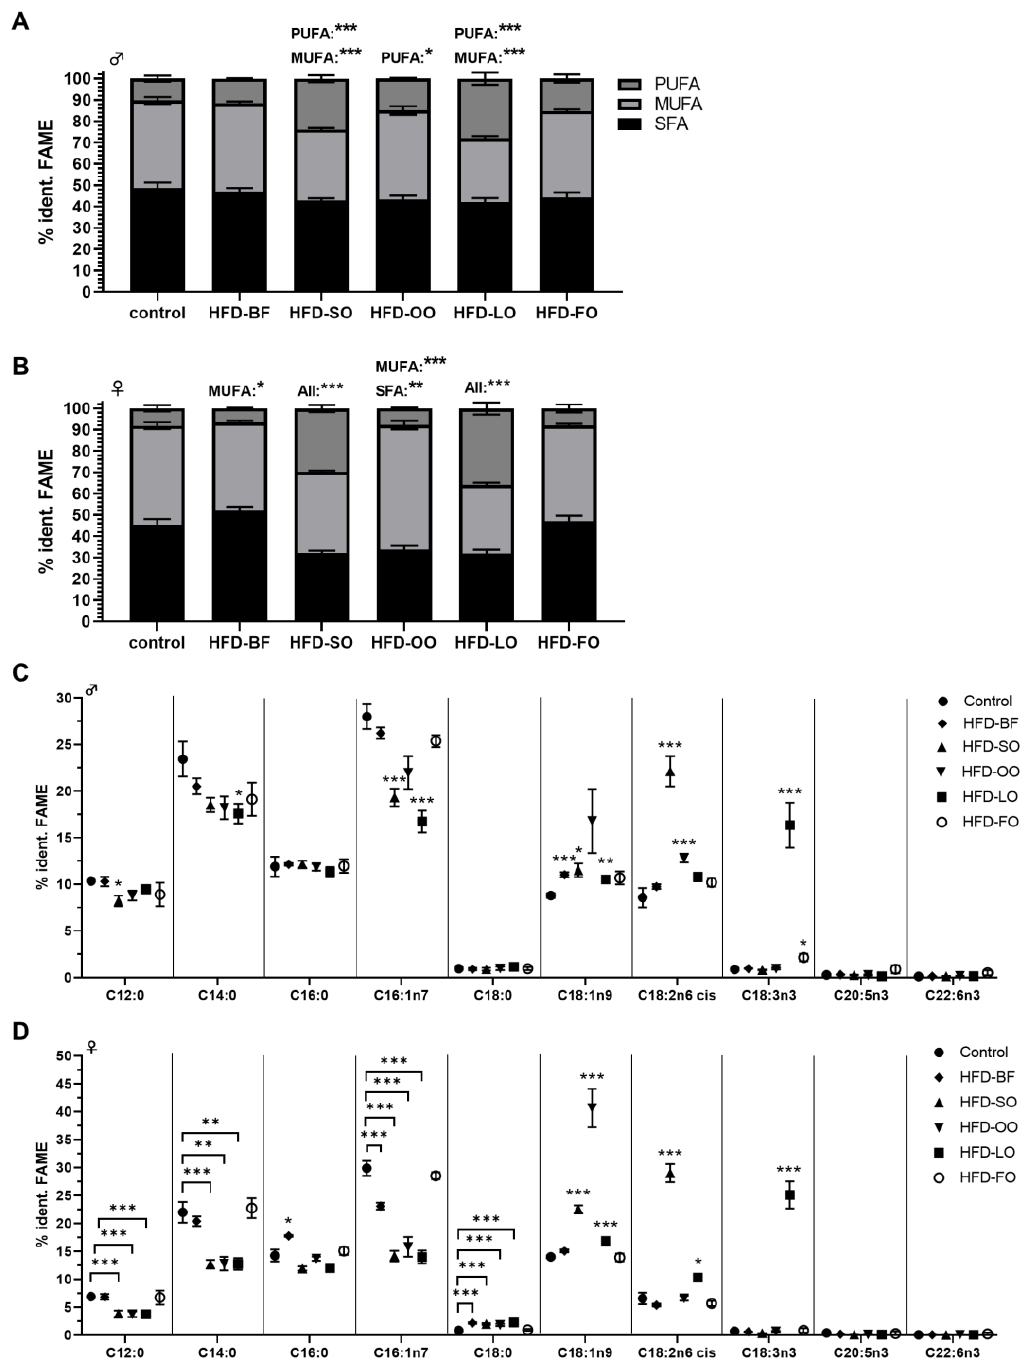
Figure 6. Alteration of the fatty acid (FA) profile of D. melanogaster after feeding on high-fat diets (HFD) with different fat qualities. Two-day-old D. melanogaster w 1118 were fed ad libitum for 3 days on a standard sugar yeast medium and the different indicated HFDs comprising 12% ( w / v ) BF, SO, OO, LO or FO, respectively. ( A – D ) The FA profiles were determined by capillary gas chromatography with flame ionization detector. The data are calculated as % identified (ident.) FA methyl esters (FAME) and displayed for ( A , C ) males and ( B , D ) females ( n = 3; N = 2175 male or N = 1350 female flies per treatment in total). Data are shown as means ± SEM. Statistical significance was assumed at * p < 0.05, ** p < 0.01, *** p < 0.001 (ANOVA). HFD-BF: high-fat diet with butterfat, HFD-SO: high-fat diet with sunflower oil, HFD-OO: high-fat diet with olive oil, HFD-LO: high-fat diet with linseed oil, HFD-FO: high-fat diet with fish oil.